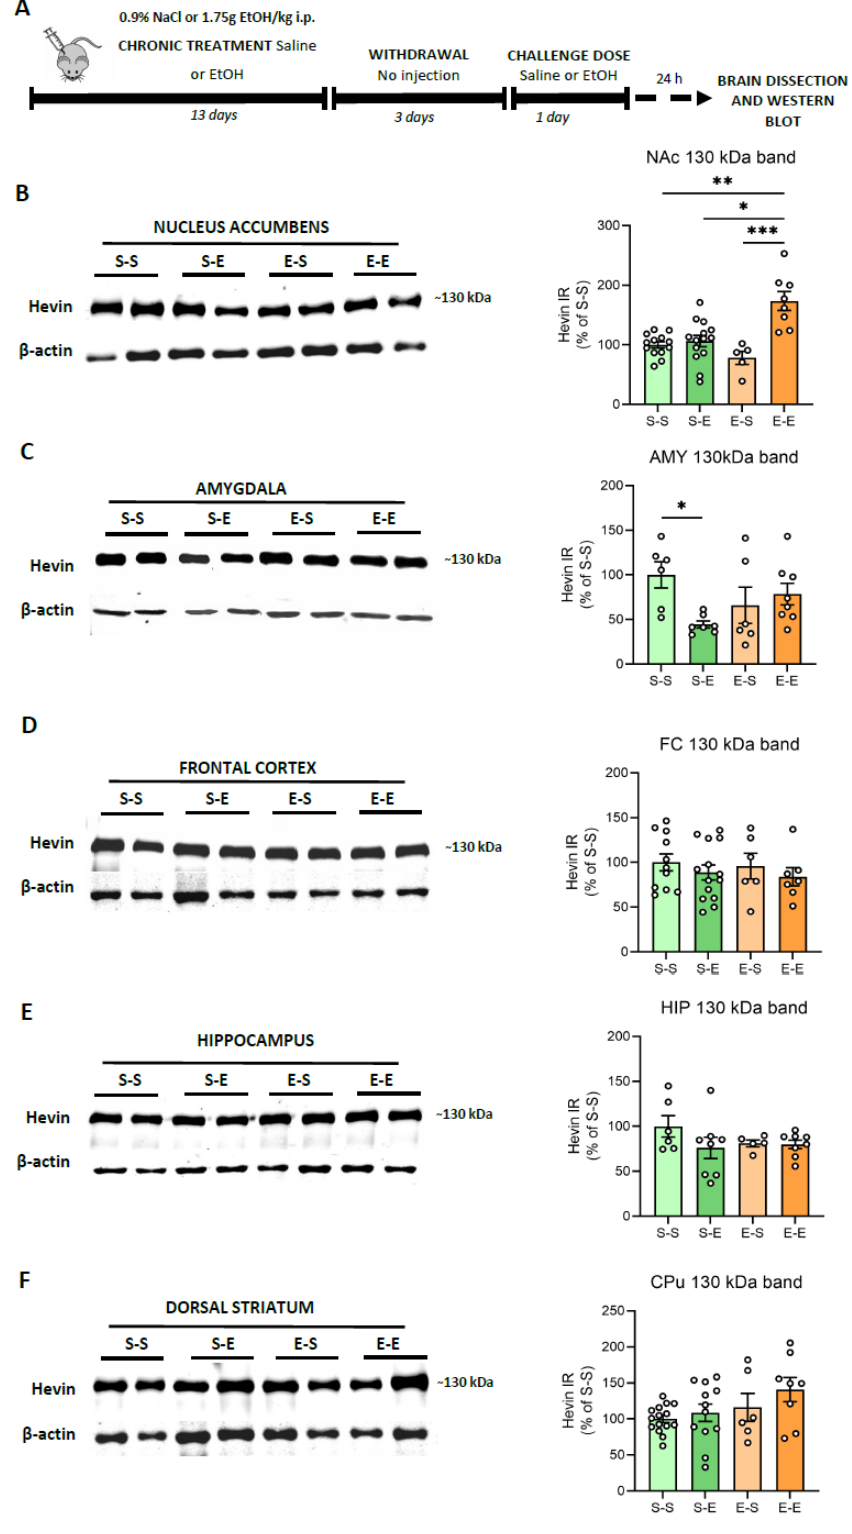
Figure 3. Hevin protein expression in the brain of mice exposed to different regimens of ethanol. ( A ) Schematic figure showing the four ethanol treatments performed. ( B – F ) Representative